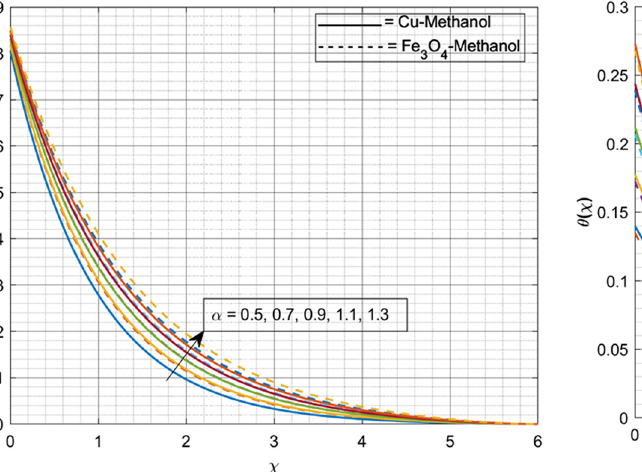
Figure 8: Sway of Bi ς on θ .